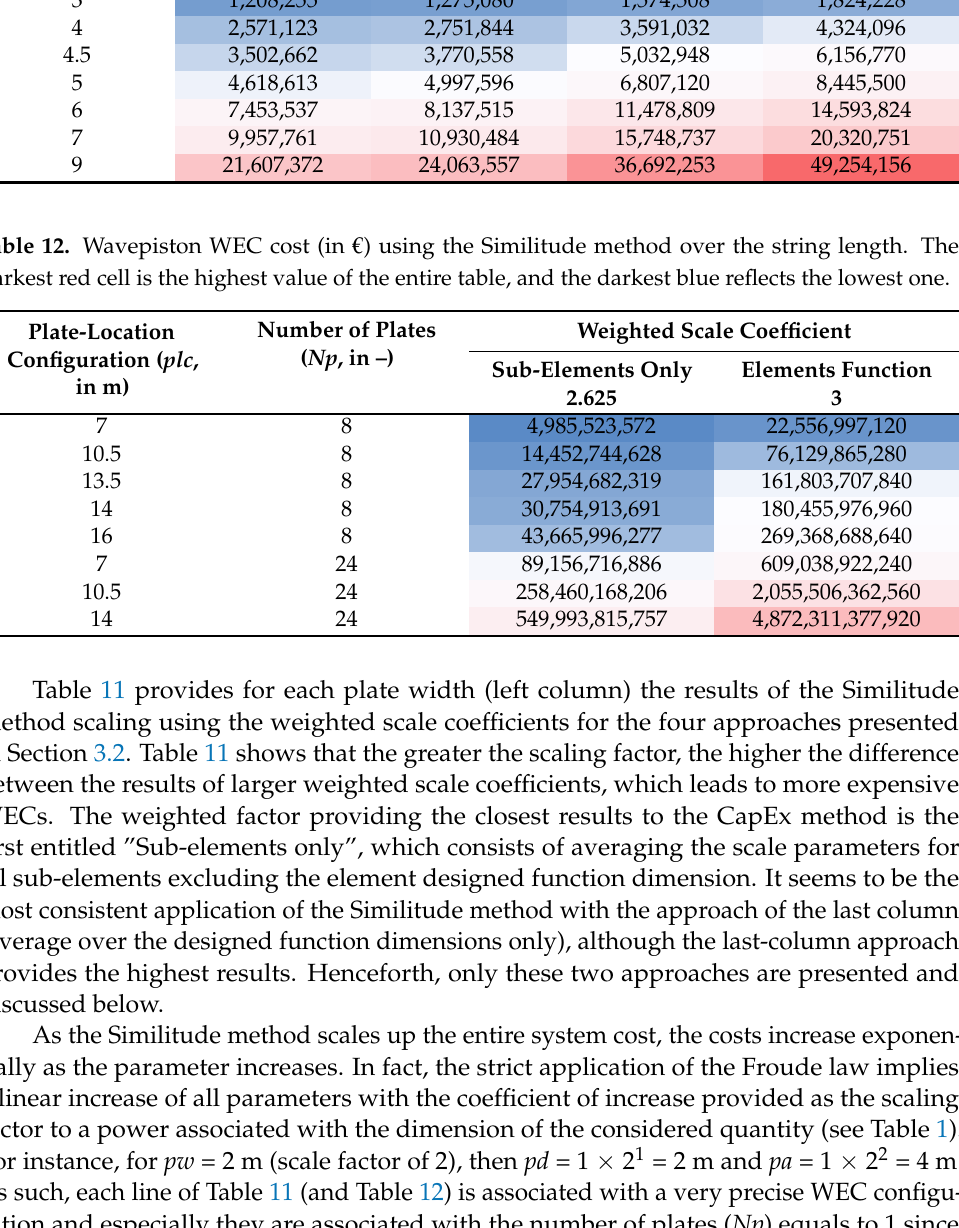
Table 11. 1-plate-based Wavepiston WEC cost (in € ) using the Similitude method over the plate width. The darkest red cell is the highest value of the entire table, and the darkest blue reflects the lowest one. Weighted Scale Coefficient Plate Width Elements and Elements Sub-Elements ( pw , in m) Only 2.625